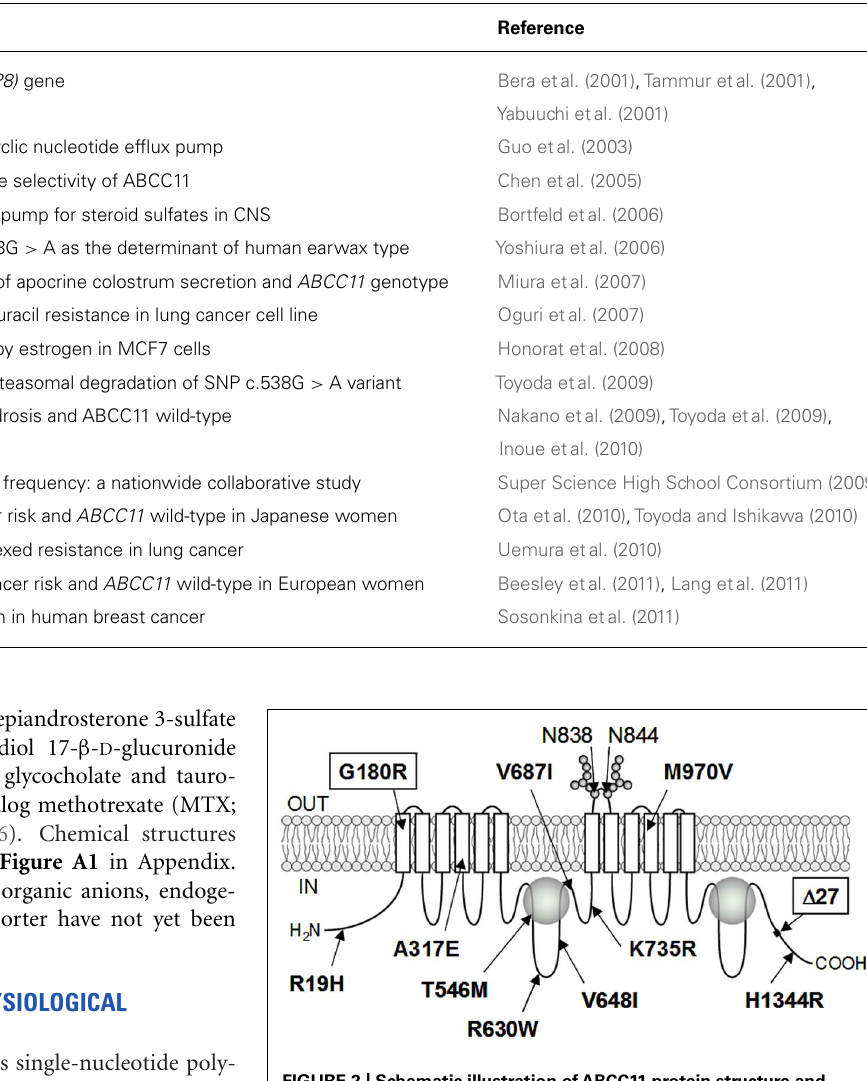
Earwax (cerumen) is a secretory product of the